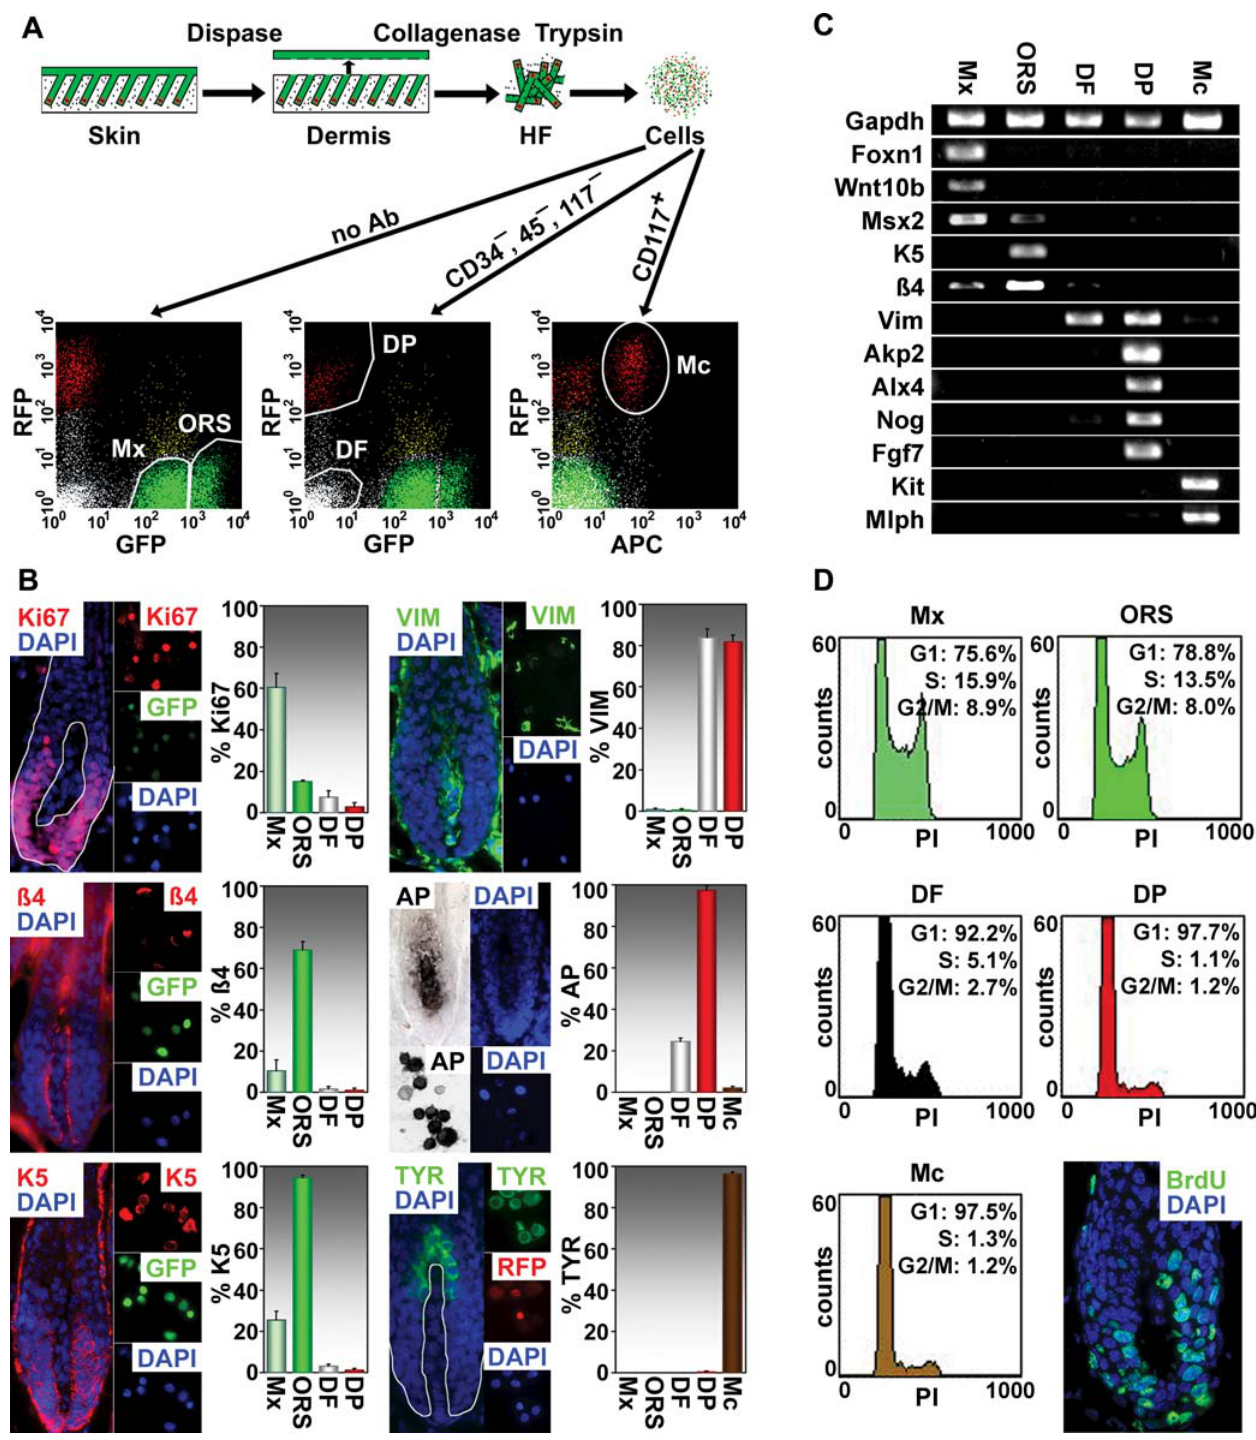
Figure 2. Isolation and Purification of Mx, ORS, DP, DF, and Mc Populations (A) Schematic of isolation procedure. After removing subcutaneous fat by dissection, and epidermis/upper follicle segment by enzymatic digestion, single- cell suspensions were prepared from pure dermis and subjected to three FACS schemes to purify five populations of cells: Mx, GFP low RFP (cid:1) ; ORS, GFP high RFP (cid:1) ; DP, RFP high GFP (cid:1) CD34 (cid:1) CD45 (cid:1) CD117 (cid:1) ; DF, RFP (cid:1) GFP (cid:1) CD34 (cid:1) CD45 (cid:1) CD117 (cid:1) ; Mc, RFP high GFP (cid:1) CD117 þ . (B) Immunofluorescence analyses of FACS isolated cell populations. Frozen skin sections (hair bulb) and relevant cytospin populations were stained with Abs as color-coded and indicated. At the right of each set is quantification of percentage of cells that expressed the marker. Note: ; 10% of DP and DF cells lysed on cytospin. and hence did not stain with any markers. b 4, b 4 integrin; Tyr, tyrosinase; Vim, vimentin; white line, basement membrane. (C) RT-PCR: cDNA fragments were resolved by agarose gel electrophoresis, and the gene detected is denoted at left. All fragments were of the expected size. Expression of Msx2, vimentin, and b 4 in multiple populations was later confirmed. (D) Cell cycle differences in cell populations. Profiles of the five purified populations were performed by FACS. Anti-BrdU immunofluorescence is from a P4 backskin follicle from a mouse injected intraperitoneally with 50 l g/g 5-bromo-2 9 -deoxyuridine (BrdU) (Sigma-Aldrich) and analyzed 4 h later. Note greatest incorporation in Mx and ORS. DOI: 10.1371/journal.pbio.0030331.g002 PLoS Biology |